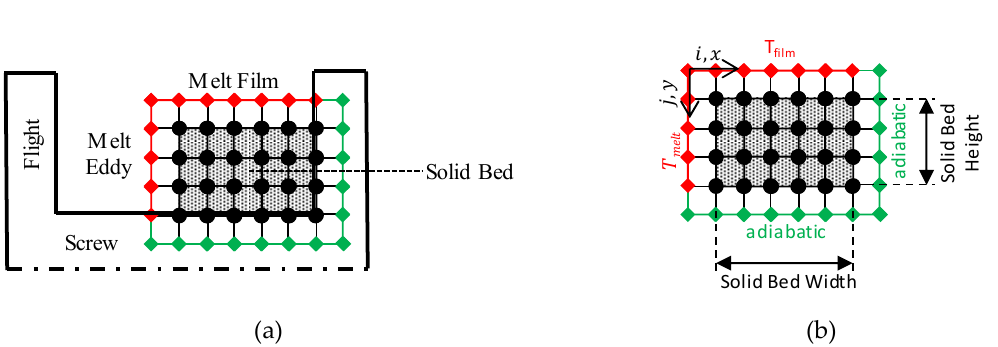
Figure 12. Representation of calculation grid for determination of solid bed temperature at ( a ) the screw and ( b ) in detail.